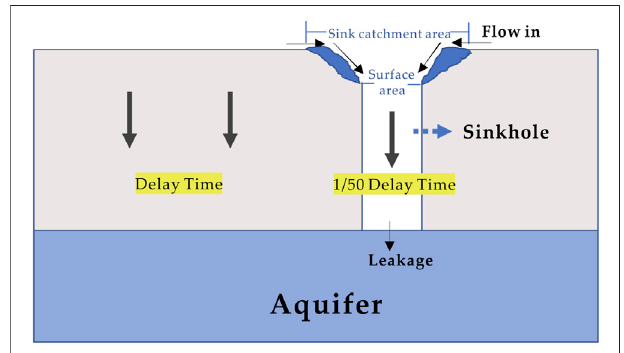
FIGURE4| Karstsinkholesimulatedbythepondmoduleinthemodi fi ed version of